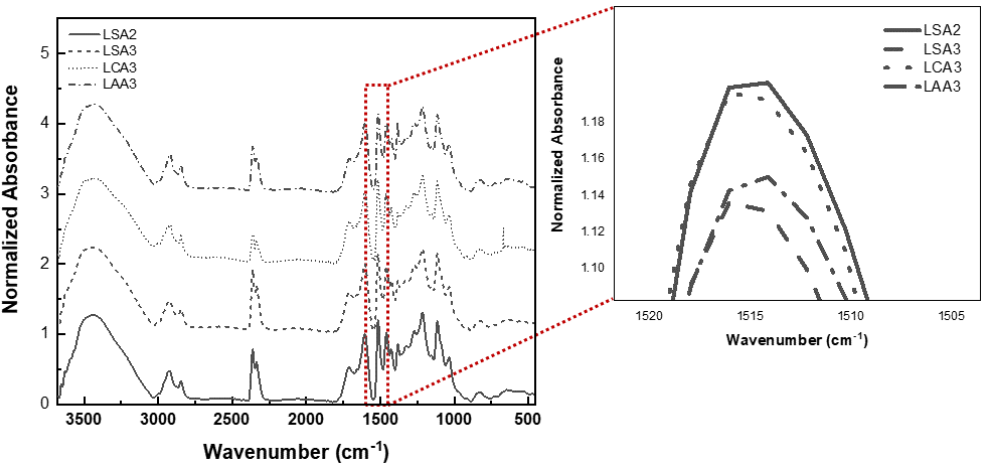
Figure 9. The results of normalized FTIR characterization of LS3, LCA3, and LAA3. Comparison of the atomic ratio H:C and O:C in the lignin LSA2, LSA3, LCA3, and LAA3 in the Van Kravelen diagram is presented in Figure 10. The result showed that